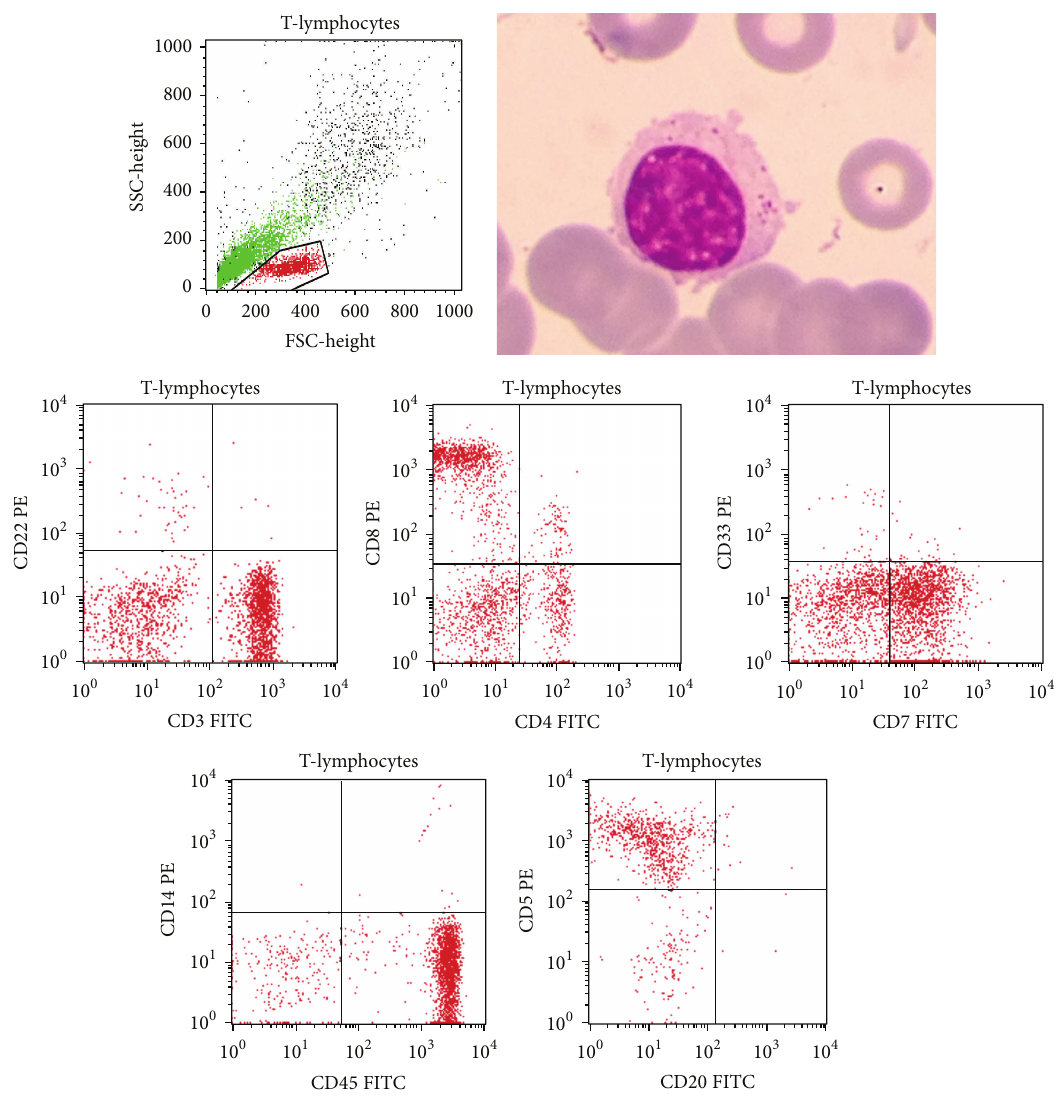
Figure 1: A T-lymphocyte showing an abundant granular cytoplasm and selected gated dual parameter dot plots of T-cells displaying CD3, CD8, CD7, CD45, and